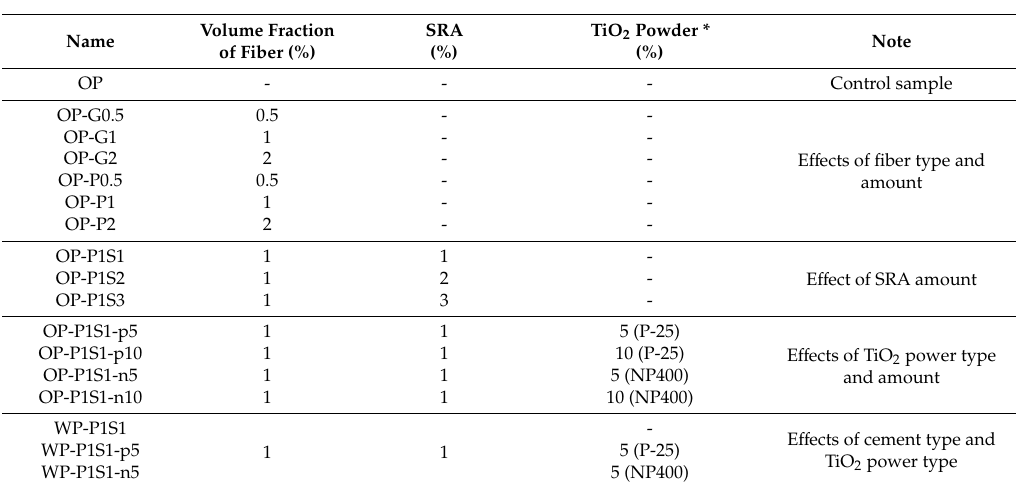
Table 2. Test variable.